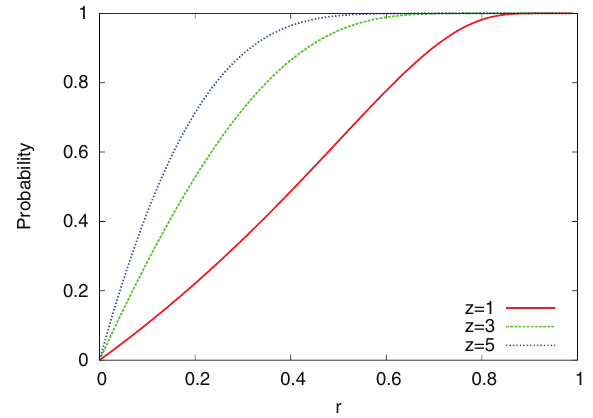
Figure 3. Illustration of the H score calculation. Let w ( l ) be the width of stage l . Let w be the minimum width across all stages, and b suppose that this minimum occurs at stage l = b ; this is the waist of the network (ties are broken so that the waist is closer to L / 2 ). Consider the sequence X = { w ( l )}, l = 1, . . . b } and the sequence ⎣ ⎦ Y = { w ( l )}, l = b , . . . L }. We denote the normalized univariate Mann- and τ , respectively. The Mann-Kendall statistic varies between X Y -1 (decreasing) and 1 (increasing), and it is approximately zero for a random sequence. We define H = ( τ − τ ) / 2; H is referred Y X to as the hourglass score. H = 1 if the DGEN is structured as an hourglass, with a decreasing sequence of b stages followed by an increasing sequence of L − b stages. In the computational modeling results, we do not consider the width of the first stage because it can never decrease in Models-1,2,3. We also define a variation of the hourglass score in which we do not take into account adjacent stages in calculating the two Mann-Kendall statistics. That statistic is